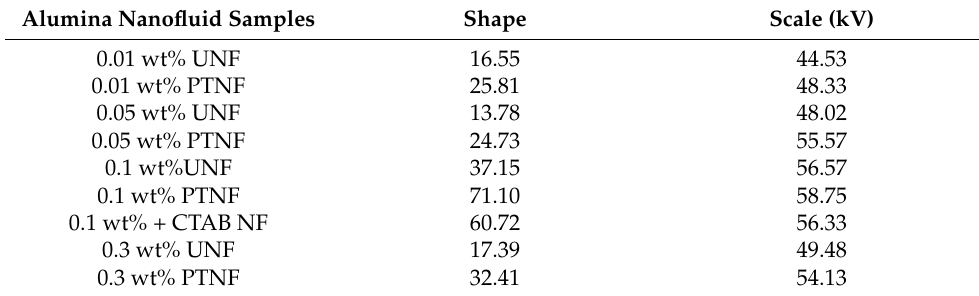
Table 2. Shape and scale values of Weibull analysis for alumina nanofluids. Alumina Nanofluid